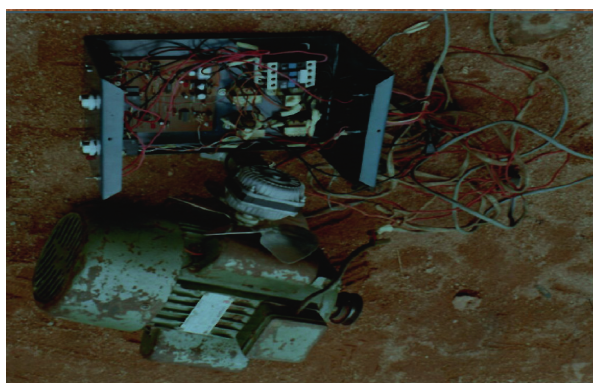
Figure 11: The system being